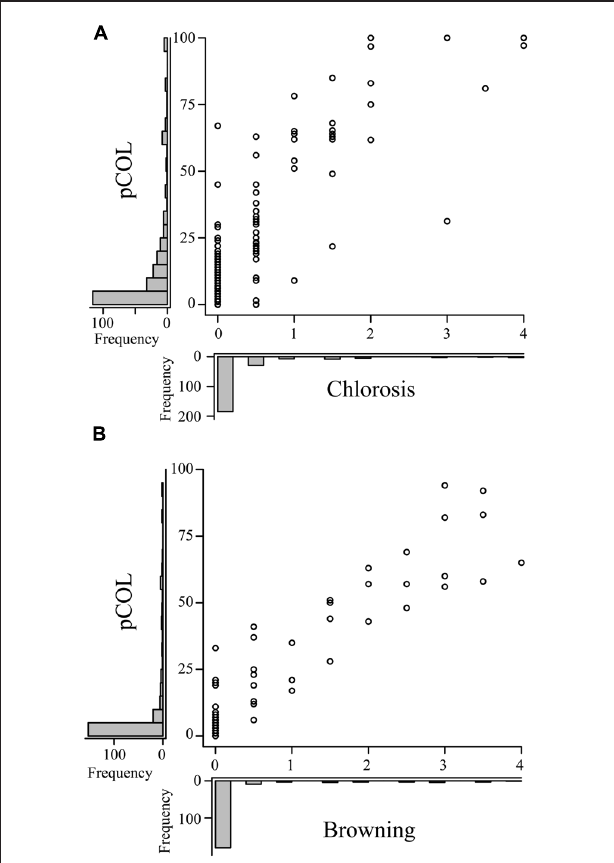
FIGURE 4 | Macroscopic symptoms of chlorosis and leaf browning in barley and B. distachyon are associated with leaf colonization by P. striiformis f. sp. tritici . Plots comparing the correlation of macroscopic chlorosis (A) and leaf browning (B) , ( x -axes) with microscopic pCOL phenotypes ( y -axes) in barley and B. distachyon , respectively, challenged with P. striiformis f. sp. tritici isolate 08/21. Histograms showing the frequency of phenotypic observations are displayed on the corresponding axis for the data shown in the